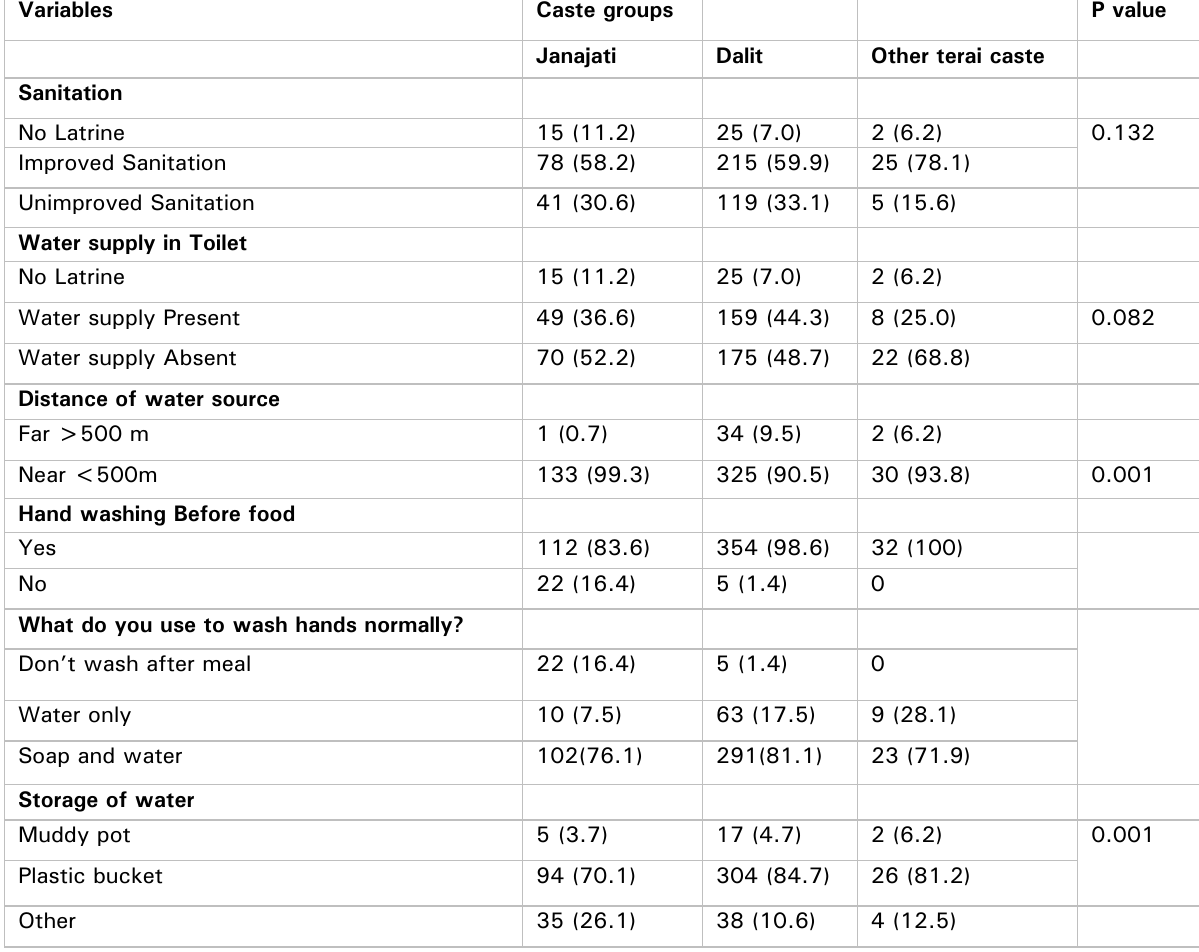
Table.4. Housing condition, Sanitation practices and hygiene among caste groups in the community